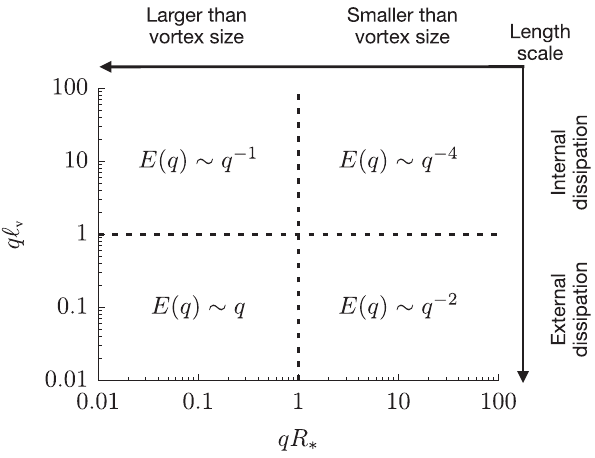
FIG. 2. Scaling regimes of turbulent flows in an active nematic film in contact with an external fluid. The different regimes are predicted at length scales ( ∼ 1 =q ) either larger or smaller than the mean vortex radius R (cid:2) , the viscous length l v ¼ η n = η thickness H of the external fluid layer. This figure summarizes the scalings in the thick-layer limit qH ≫ 1 ; see Fig. 6 for the predictions in the thin-layer limit qH ≪ 1